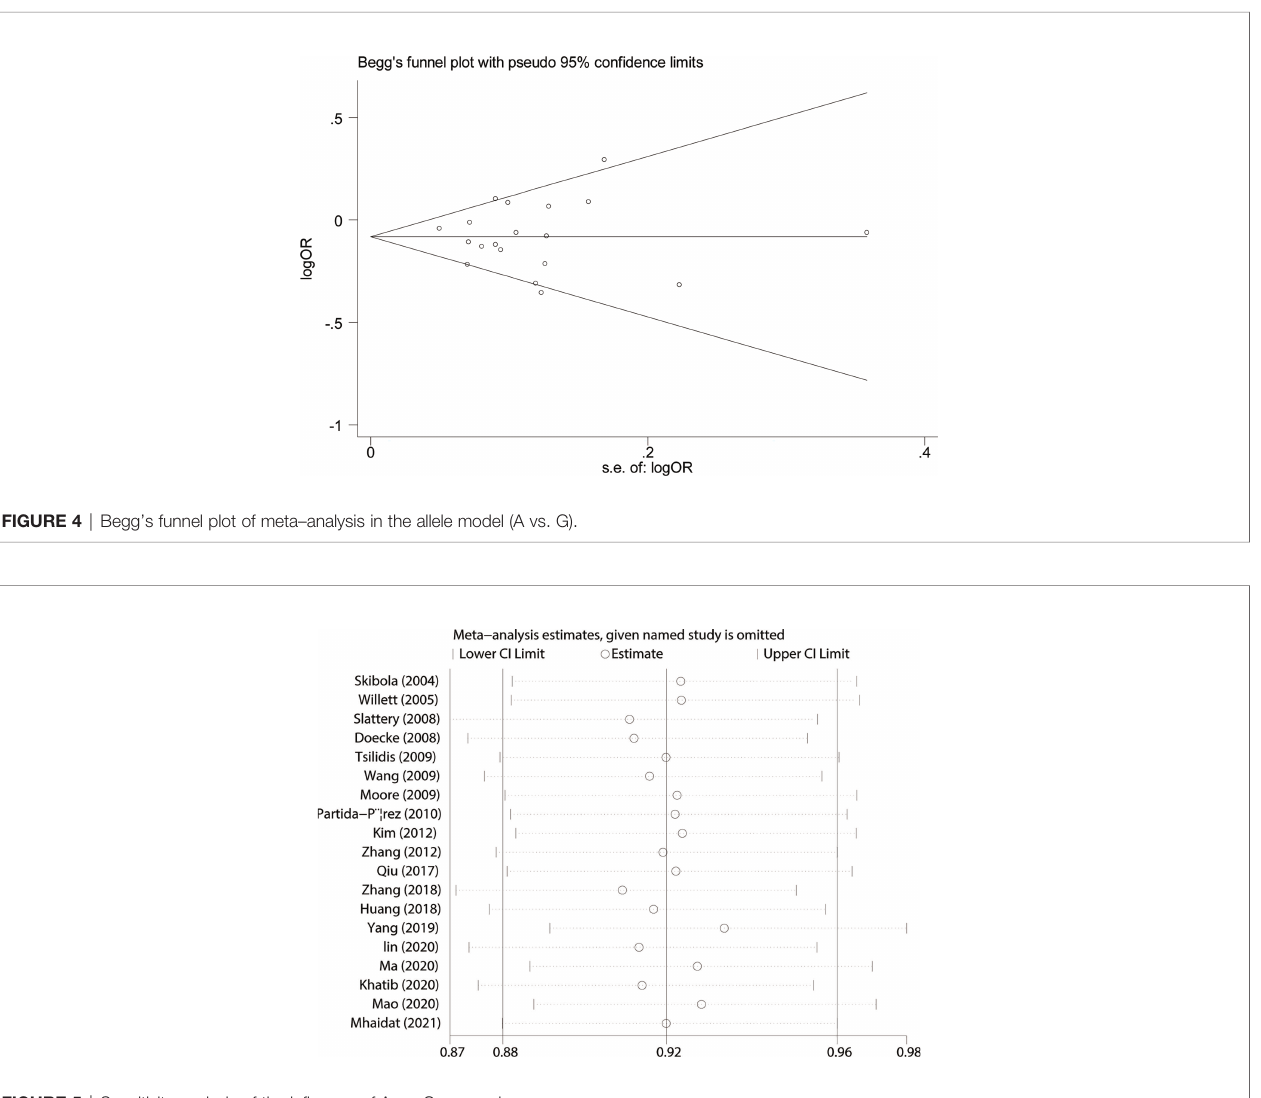
FIGURE 5 | Sensitivity analysis of the in fl uence of A vs. G